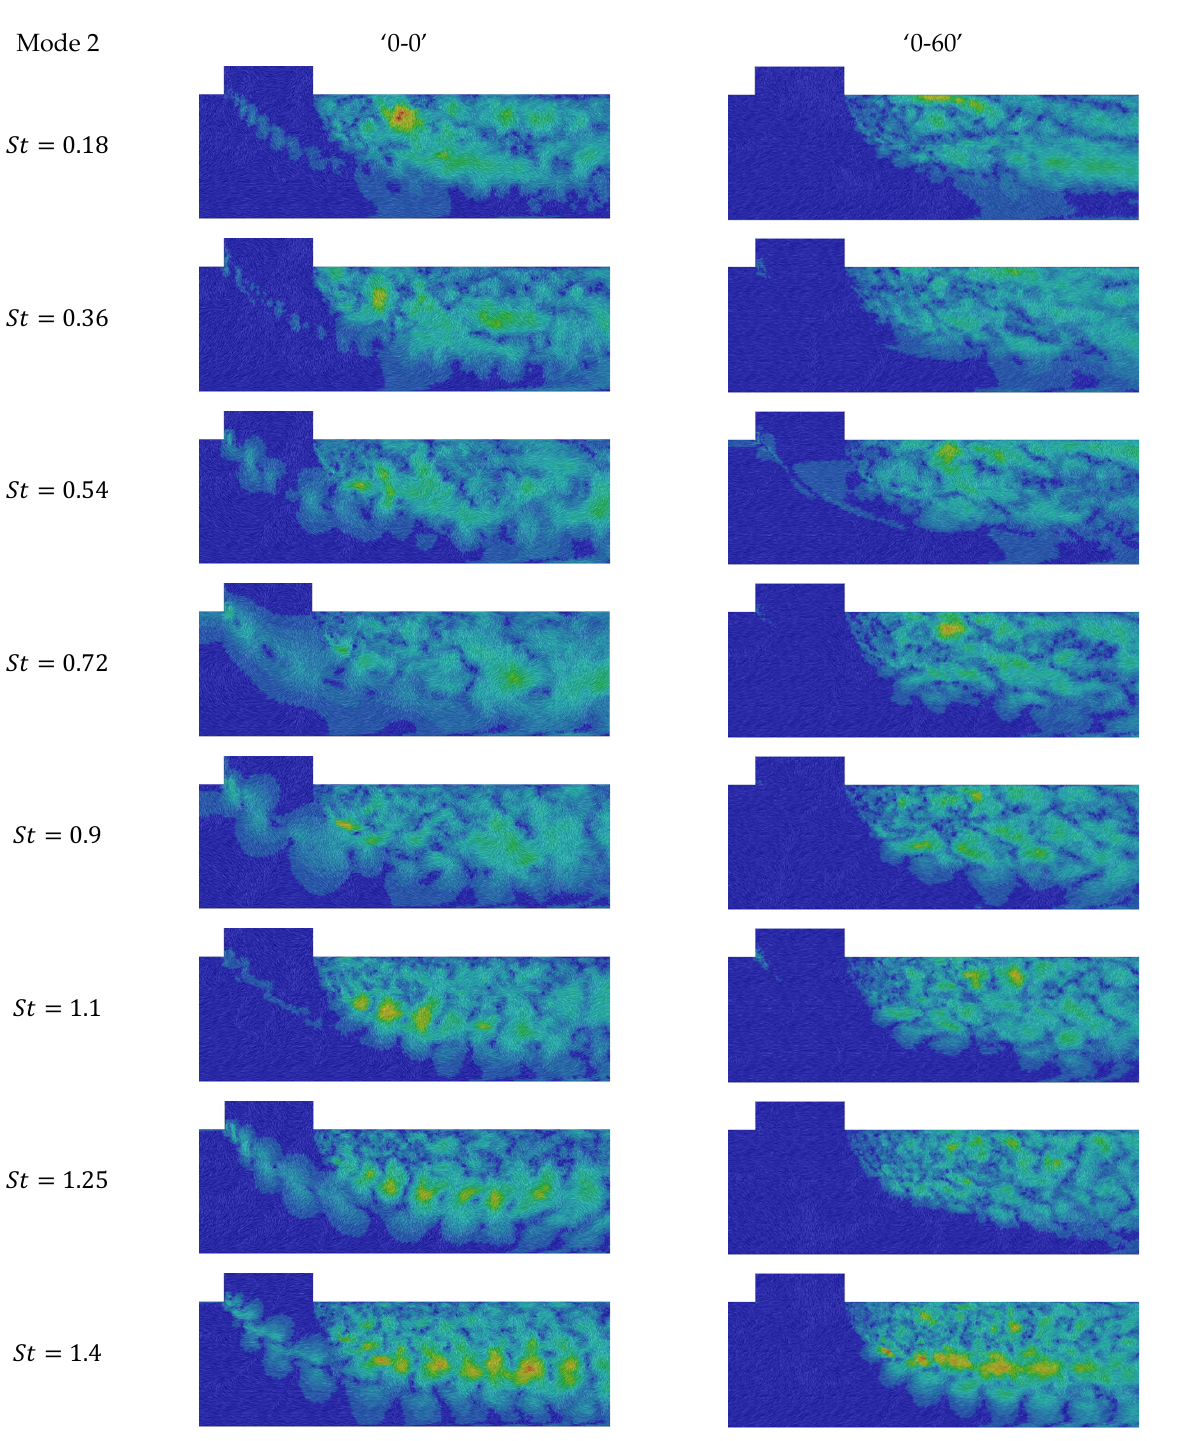
Figure 24. Contour plots of mode 2 of in-plane velocity vector coloured by mode magnitude for XZ plane.